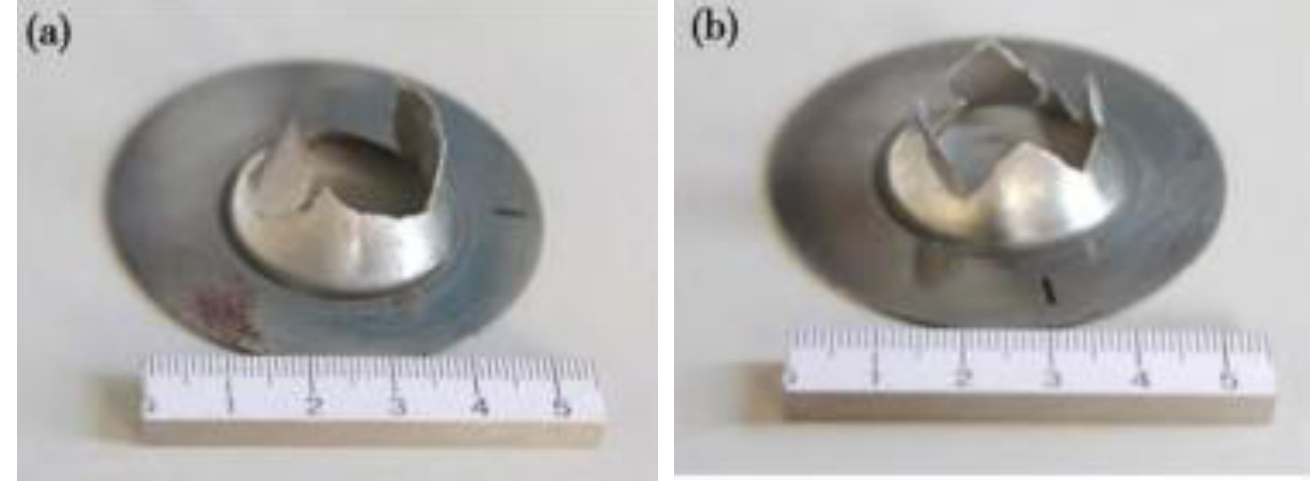
Figure 6. Blasted specimen after disk test ( a ) He environment and ( b ) H2 environment.